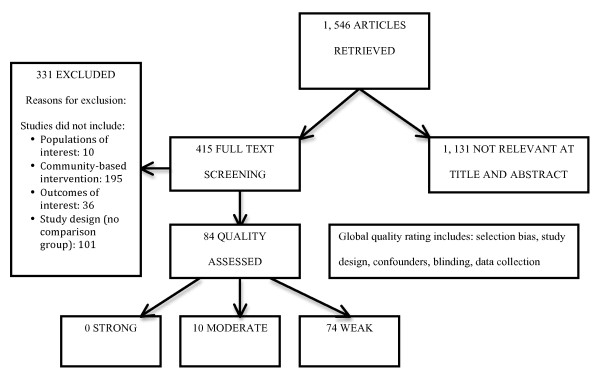
Flowchart of included/excluded studies.